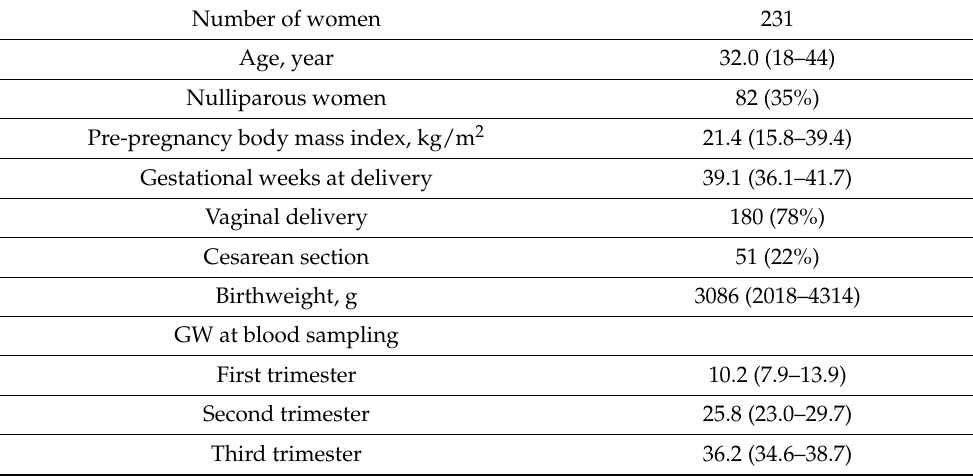
Table 1. Demographic characteristics.